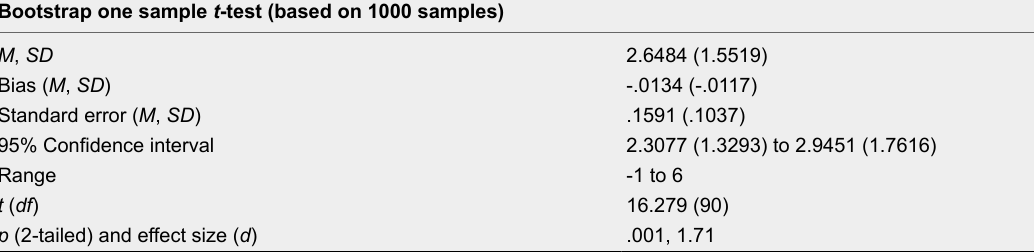
Results of the One-Sample T-Test Testing the Change in Opinions From Baseline to One-Week After Watching the Video Bootstrap one sample t -test (based on 1000 samples) M , SD 1.9868 (1.6289) Bias ( M , SD ) -.0064 (-.0175) Standard error ( M , SD